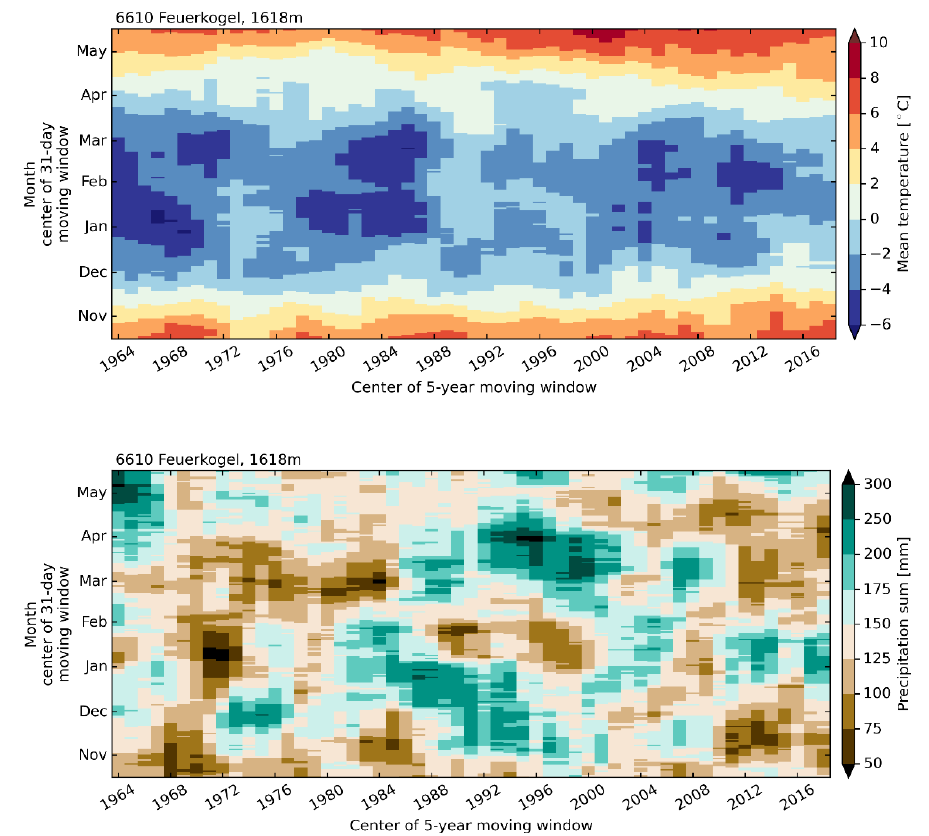
Figure 12. Moving average over shifting horizon (MASH) analysis of air temperature ( top ) and precipitation ( bottom ) for the period 1 October–31 May 1961–2020 for the location of the station Feuerkogel (1618 m) extracted from the SPARTACUS observation grid dataset. The temperature time series is averaged over the horizontal and vertical time axis using a 5 year and 31-day moving window, respectively. A 31-day moving accumulation window is used for the